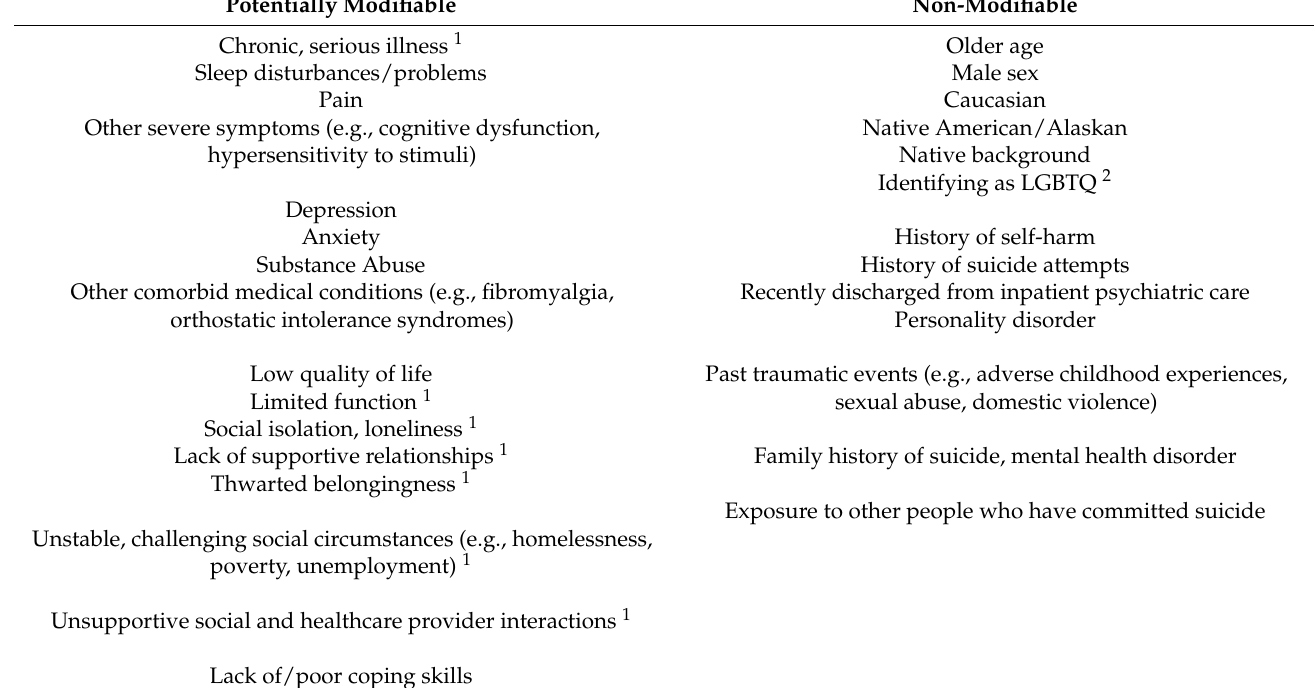
Table 1. Risk factors for